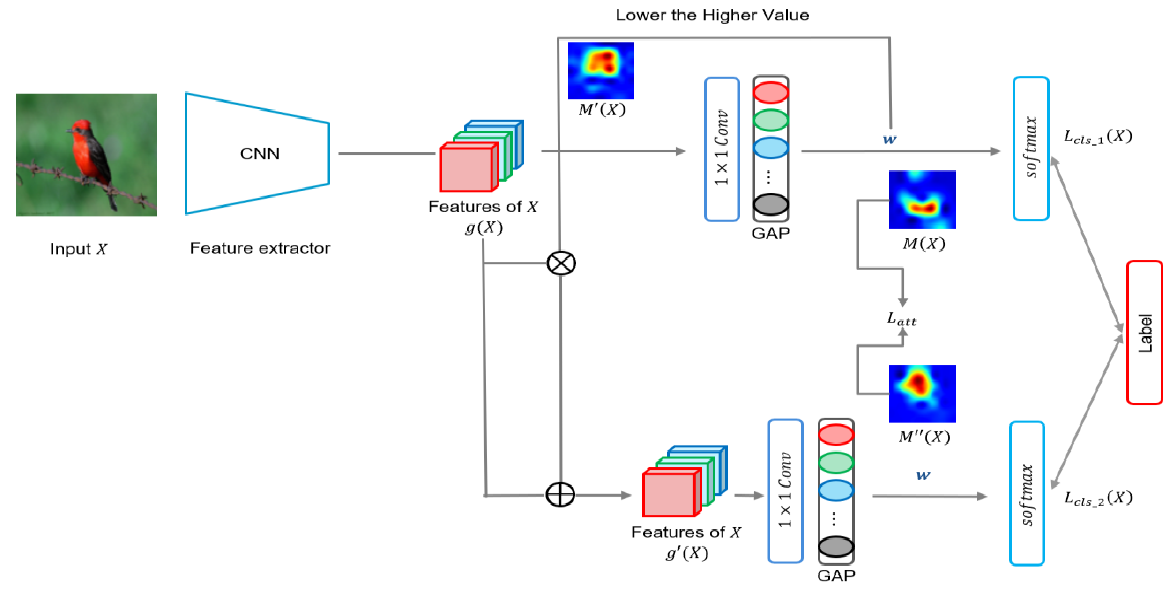
Figure 3. Structure of the proposed method.